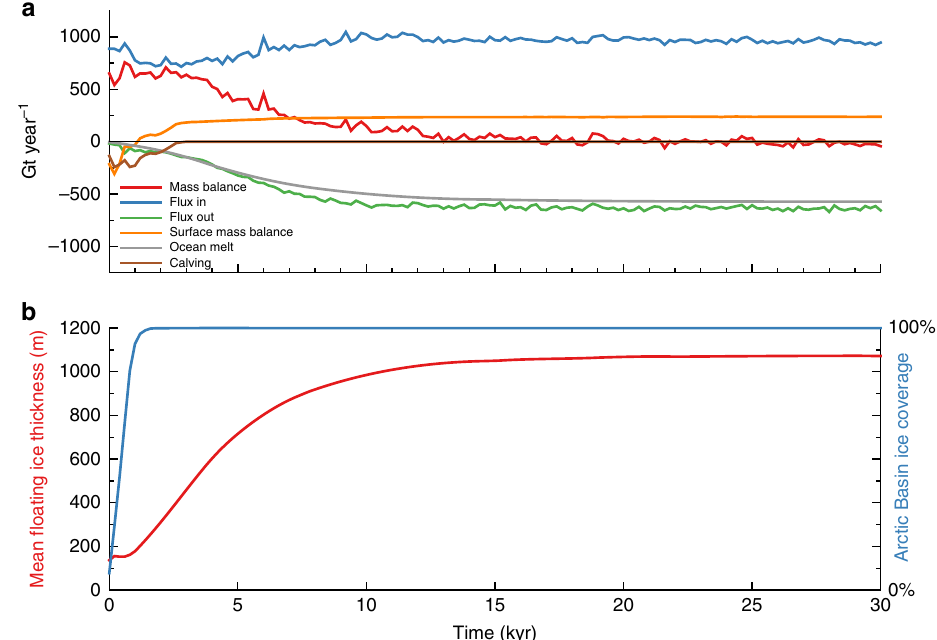
Fig. 4 Ice shelf mass balance through time. a Mass balance for fl oating ice within the Arctic Basin, de fi ned by location of grounding line, with a cutoff in the Fram Strait at 80 ˚ N, for simulation shown in Fig. 3b. Calving is zero when the calving front has moved outside of the Arctic Basin. b Mean shelf thickness and fraction of Arctic Basin with ice